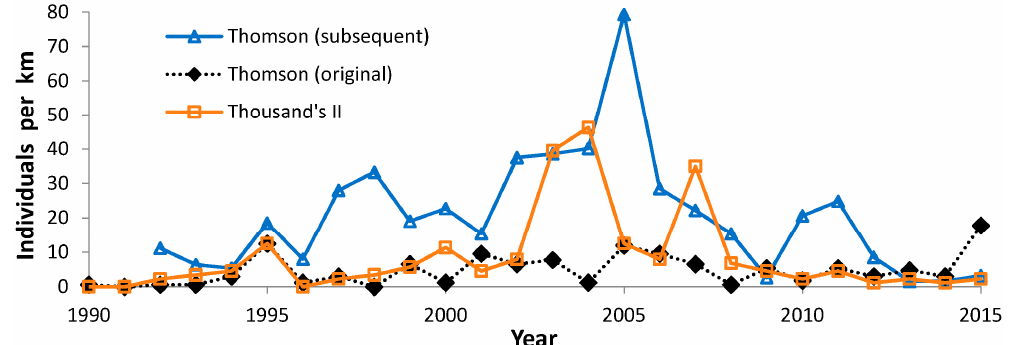
Figure 3. Regal fritillary individuals per km on peak survey per year at the Thomson Prairie Complex: Thomson (original acquisition), Thomson (subsequent acquisition), and Thousand’s II.